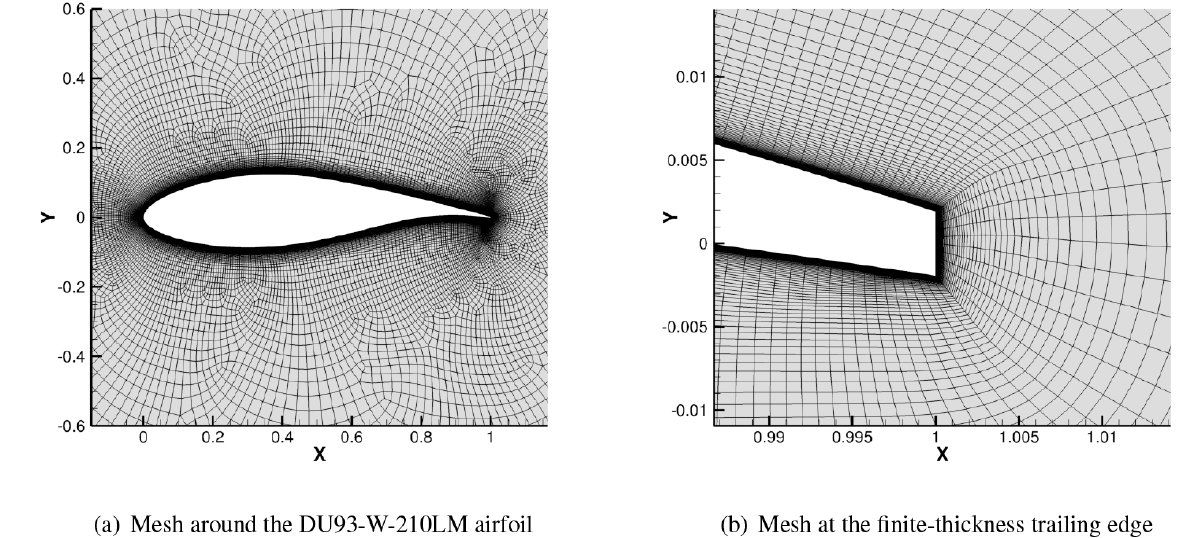
Figure 2. Example of a computational mesh for the DU93-W-210LM